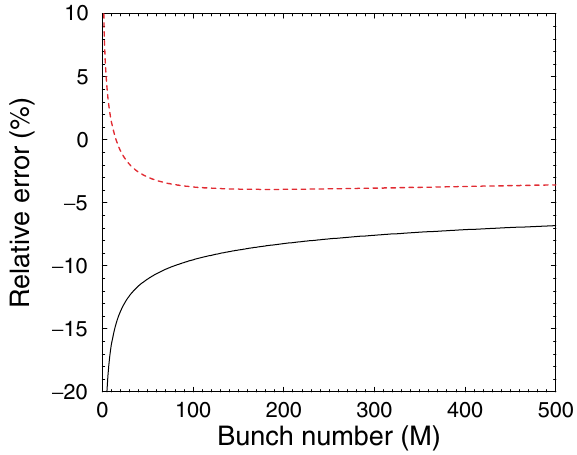
FIG. 3. (Color) The relative error defined in Eq. (75) as a function of the bunch number M (cid:1) t=(cid:10) stands for the case of single-bunch offset and the dashed curve for the case of an injection error.